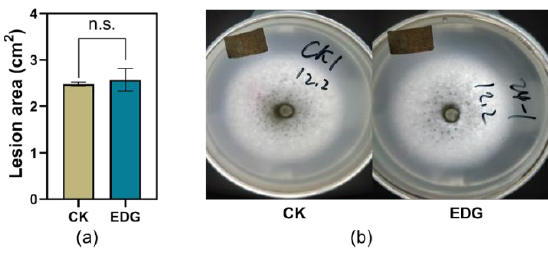
Figure 7. Effect of EDG on the performance of C. camelliae. ( a ) Mean infection area of C. camelliae on potato dextrose agar medium supplemented with EDG (±SE, n = 5); n.s. indicates no significant difference between treatment and control ( p > 0.05, Student’s t -test); ( b ) photos of the infections.